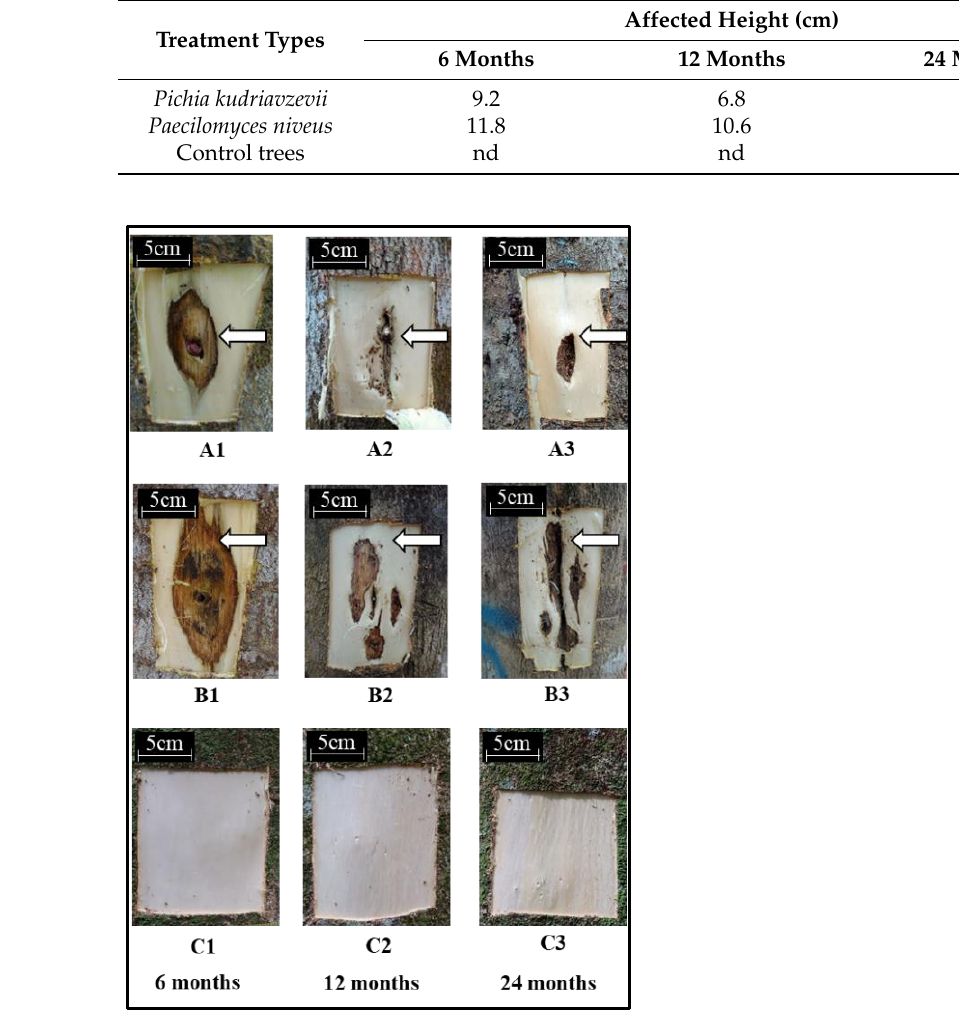
Figure 5. Discolouration Zone around Inoculation Position of Inoculated A. malaccensis Trees Meas- ured on Medium Diameter Class at the Middle Position (130 cm) from the ground. Note: the arrow indicated wood tissue colour which changed from pale brown to yellow-brown until the trunk surface was changed to the original colour. ( A1 – A3 ) = inoculated with Pichia kudriavzevii Boidin, Pignal and Besson, ( B1 – B3 ) = inoculated with Paecilomyces niveus Stolk and Samson, ( C1 – C3 ) = uninoculated (control)